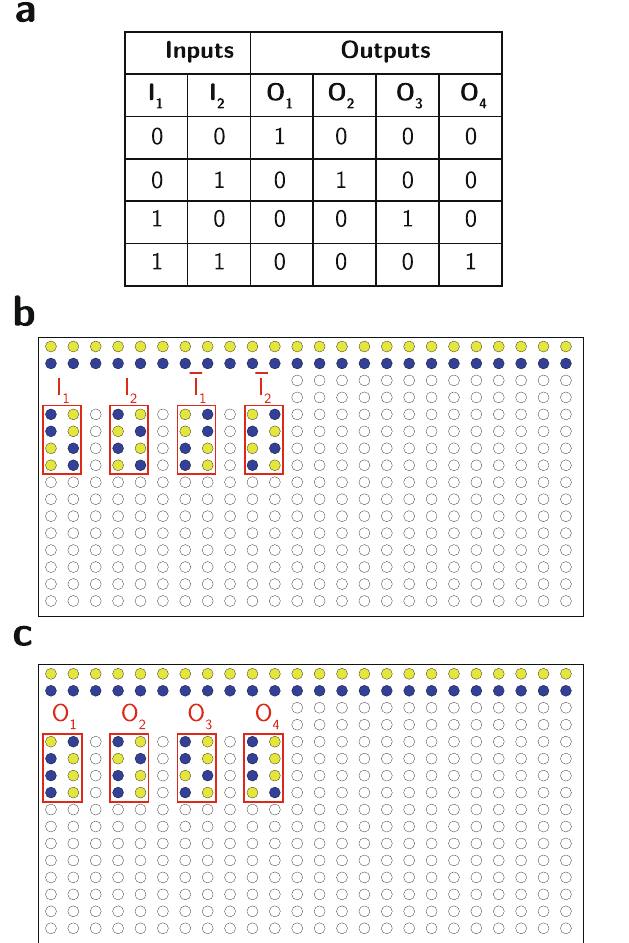
Fig. 4 | Implementation of the 2-Bit Decoder using the liquid handler. a The truthtableforthe2-bitdecoder. b Theinitialacid(yellow)andbase(blue)stocksof the encoded inputs and their complements. c The fi nal output of the acid-base circuit after applying the AND gate.